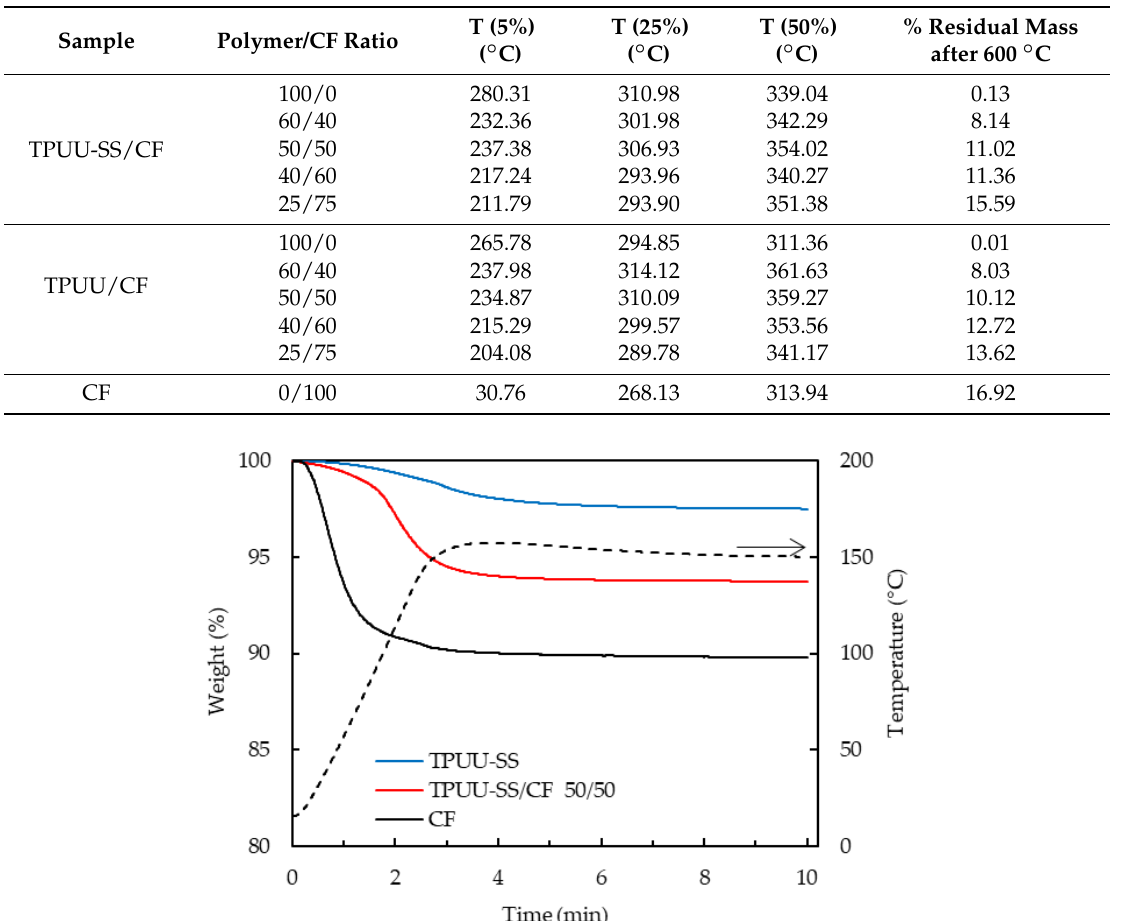
Table 2. Thermal characterization of TPUU-SS/CF, TPUU/CF and CF samples.